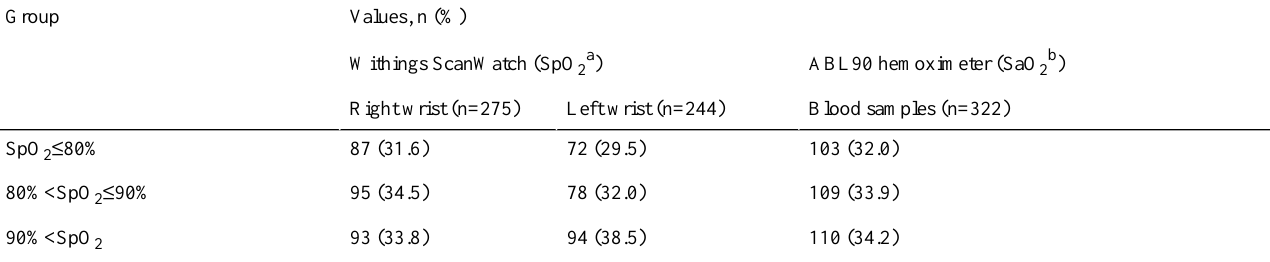
Table 3. Distribution among the SpO 2 groups of the conclusive measurements collected by the Withings ScanWatch. The corresponding distribution of SaO 2 values given by the ABL90 hemoximeter are also reported.